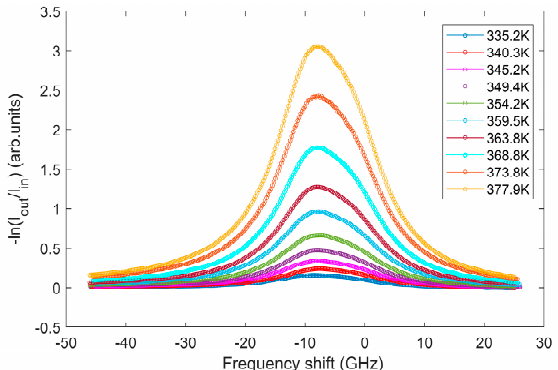
Figure 7. Experimental results at various temperatures. The temperature of the cell center is plotted as a solid line, the temperature of the cell surface is plotted as a dash–dotted line, and the temperature of the oven is plotted as a dotted line.